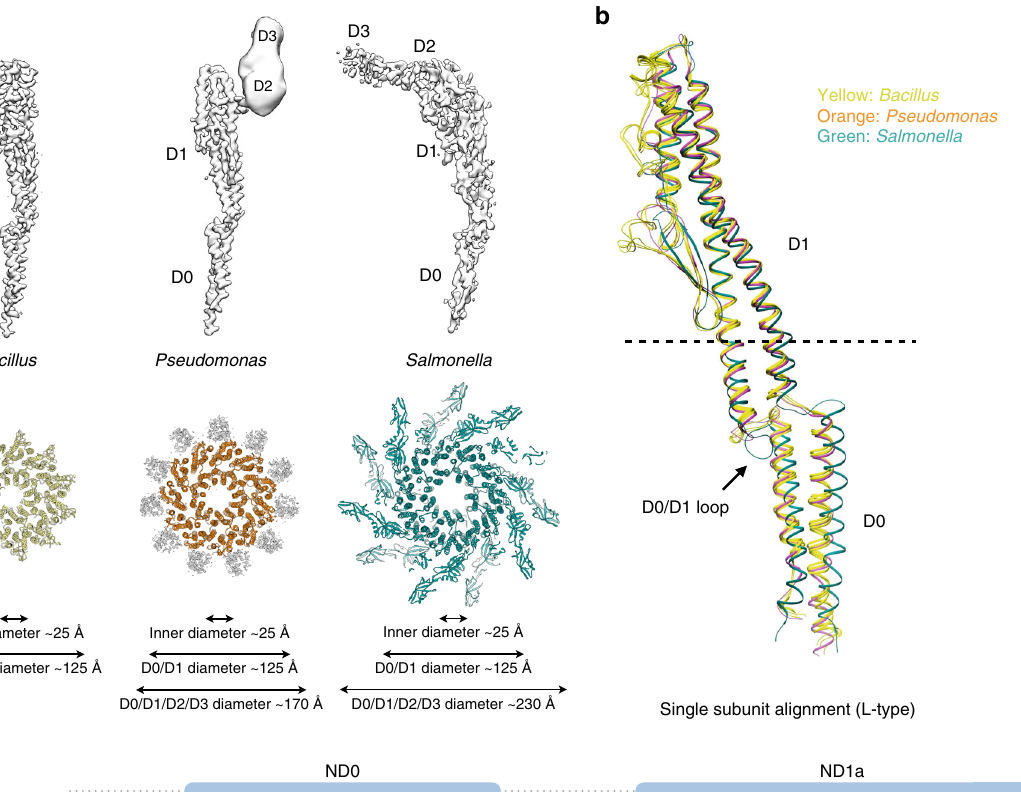
Yellow: Bacillus Orange: Pseudomonas Green: Salmonella